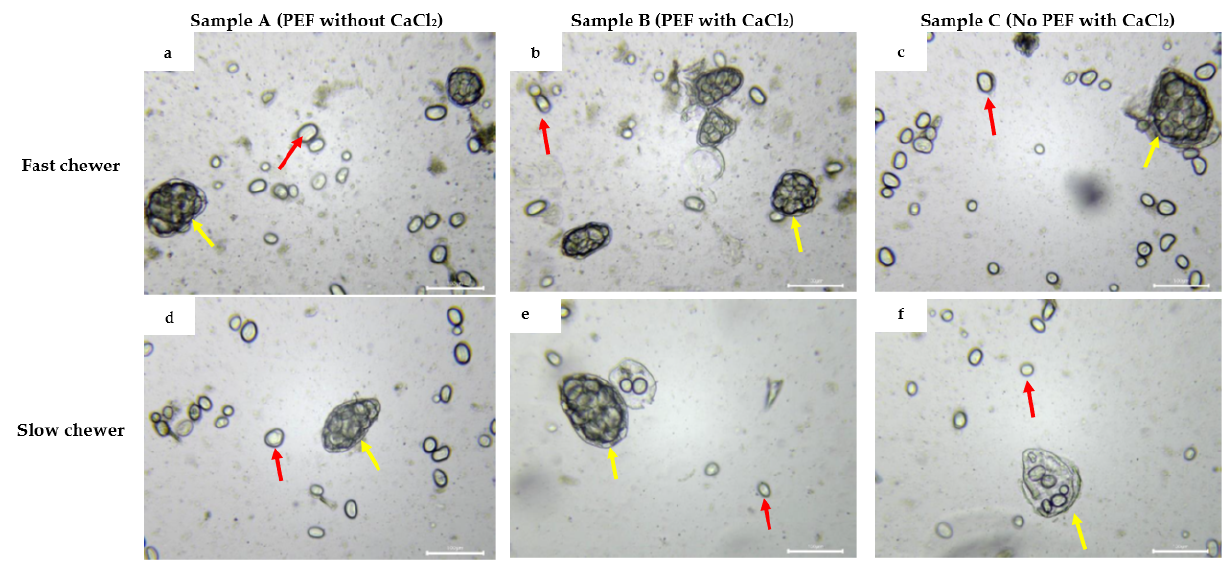
Figure 7. Selected light microscopic images of the starch granules from the oral bolus of three cooked black bean samples (A: PEF and thermally processed without CaCl 2 addition; B: PEF and thermally processed with CaCl 2 addition; and C: No PEF, thermally processed with CaCl 2 ) after in vivo mastication of the fastest ( a – c ) and slowest ( d – f ) chewers. Yellow arrows show the black bean cotyledon cells and red arrows point to free starch granules. Images were viewed under 10× magnification. Scale bar = 100 µm.